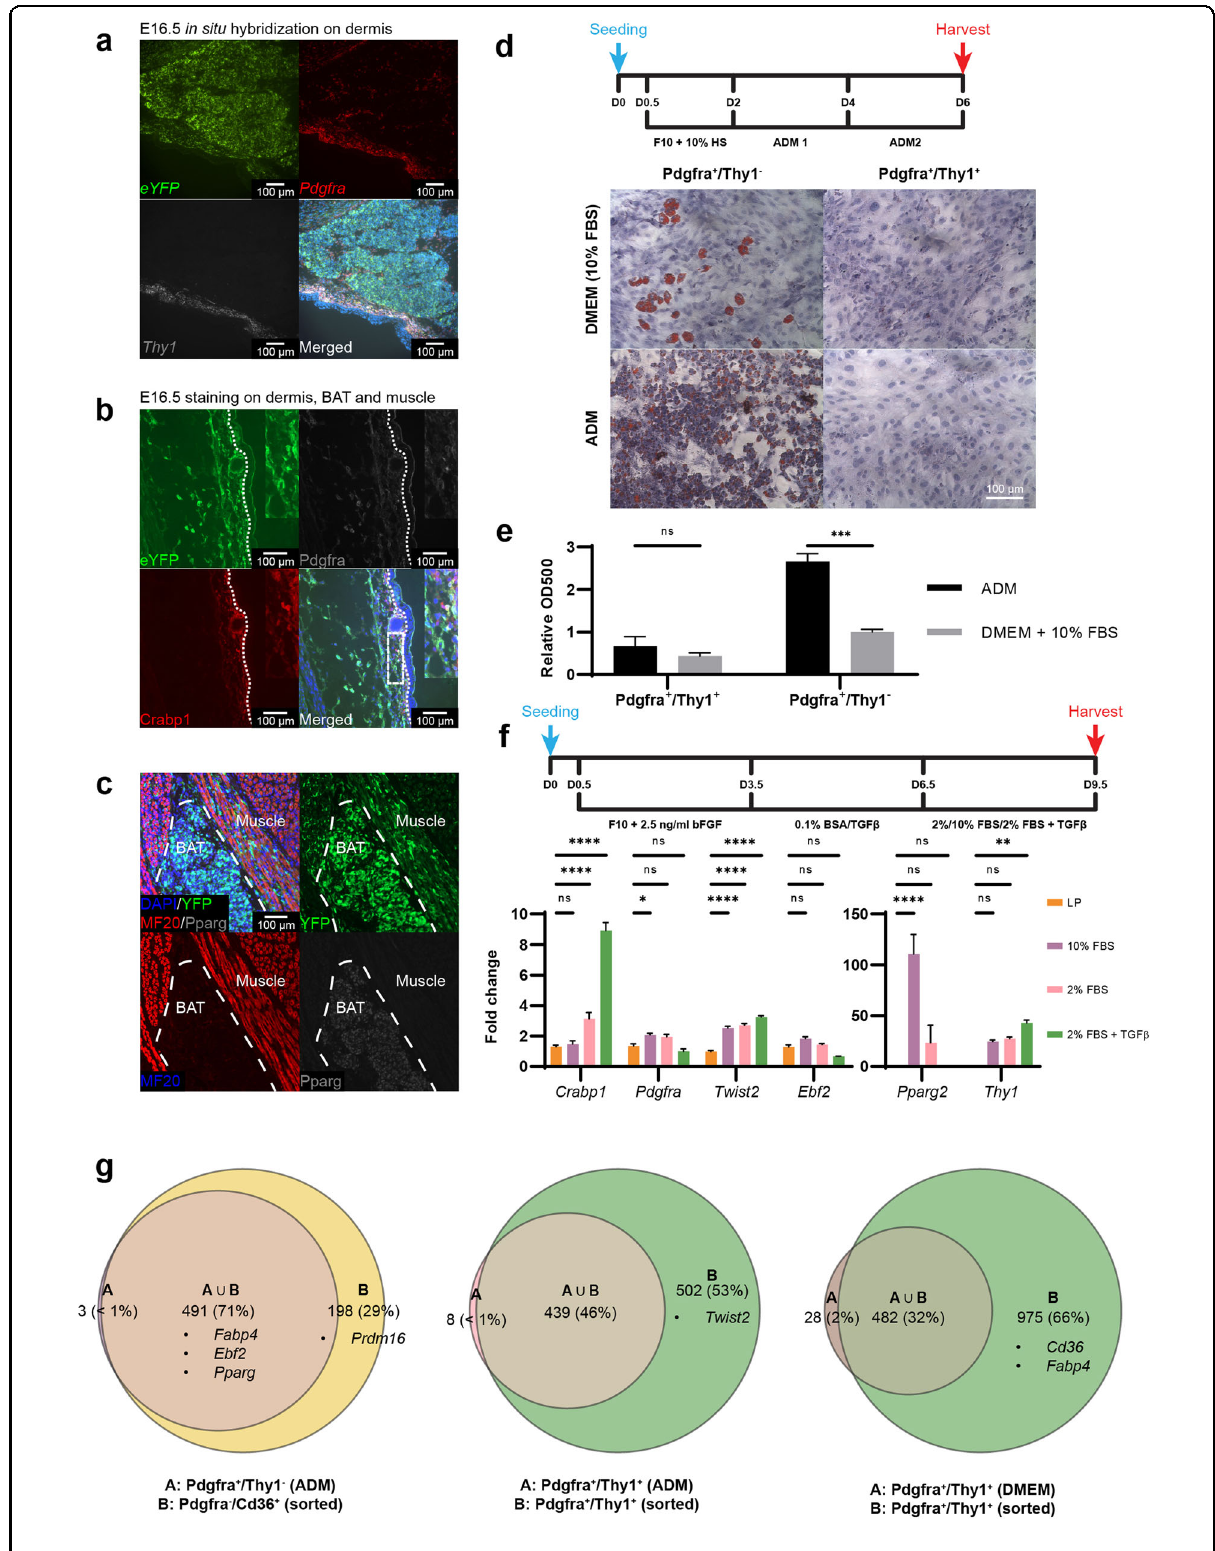
Fig. 5 (See legend on next